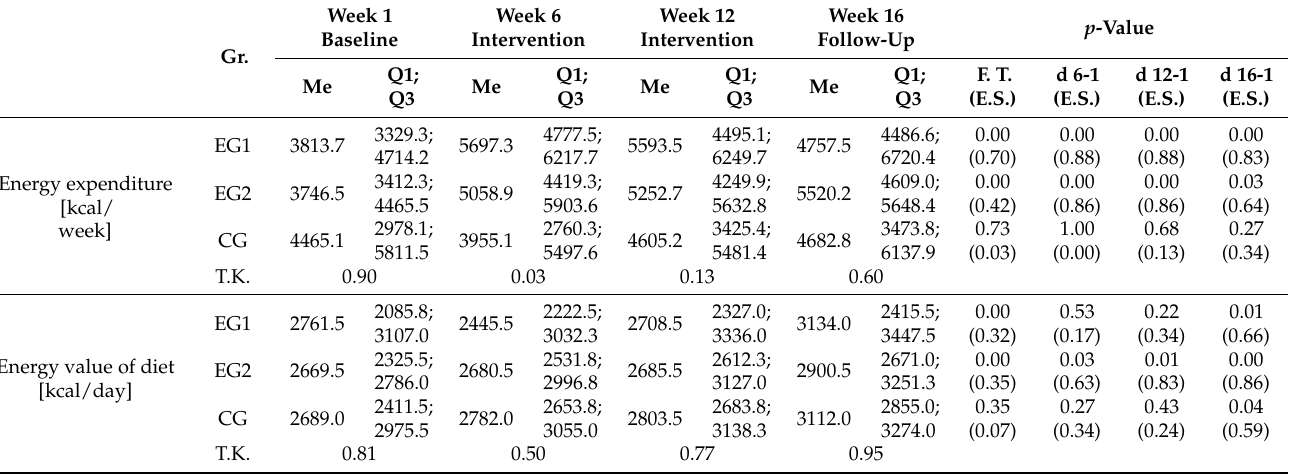
Table 3. Energy expenditure and energy value of the research participants’ diets in the aerobic group (EG1), aerobic-resistance group (EG2), and control group (CG).